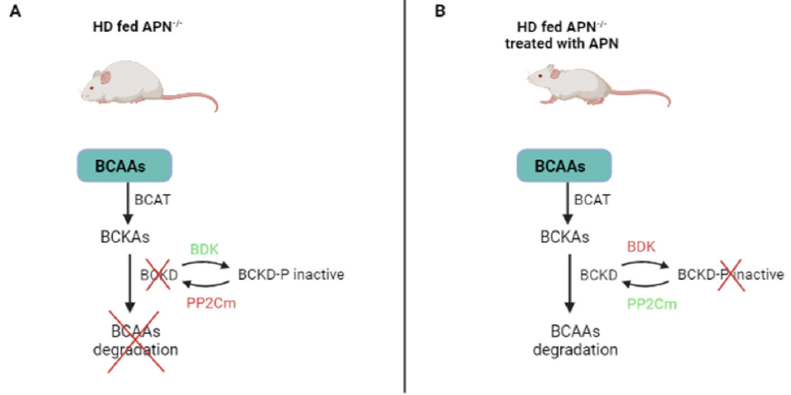
Figure 4. APN regulates BCAA catabolism. ( A ) In the absence of APN, BDK is upregulated and inhibits BCAA catabolism. ( B ) In the presence of APN, BDK is downregulated and BCAAs are degraded. HD: high-fat diet; APN: adiponectin; APN − / − mice: adiponectin knockout mice;